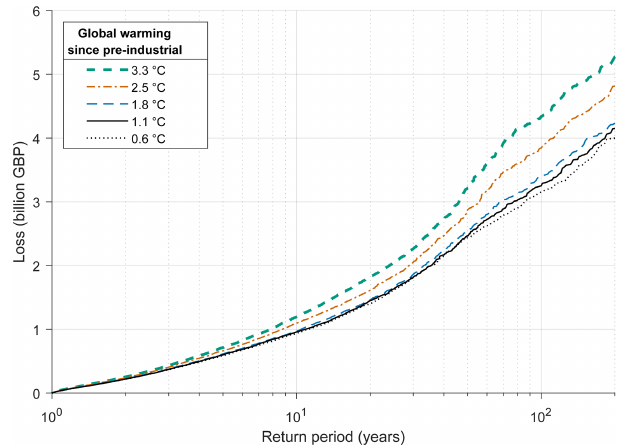
Figure 5. Great Britain loss-exceedance curves due to flooding (in GBP billion at 2020 values) for different specific global warming levels since the pre-industrial